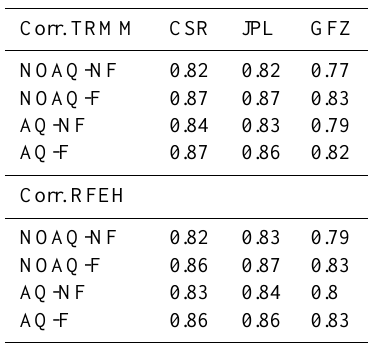
Table 5. Correlations of the model TWS with GRACE TWS (from 2002 to 2007).